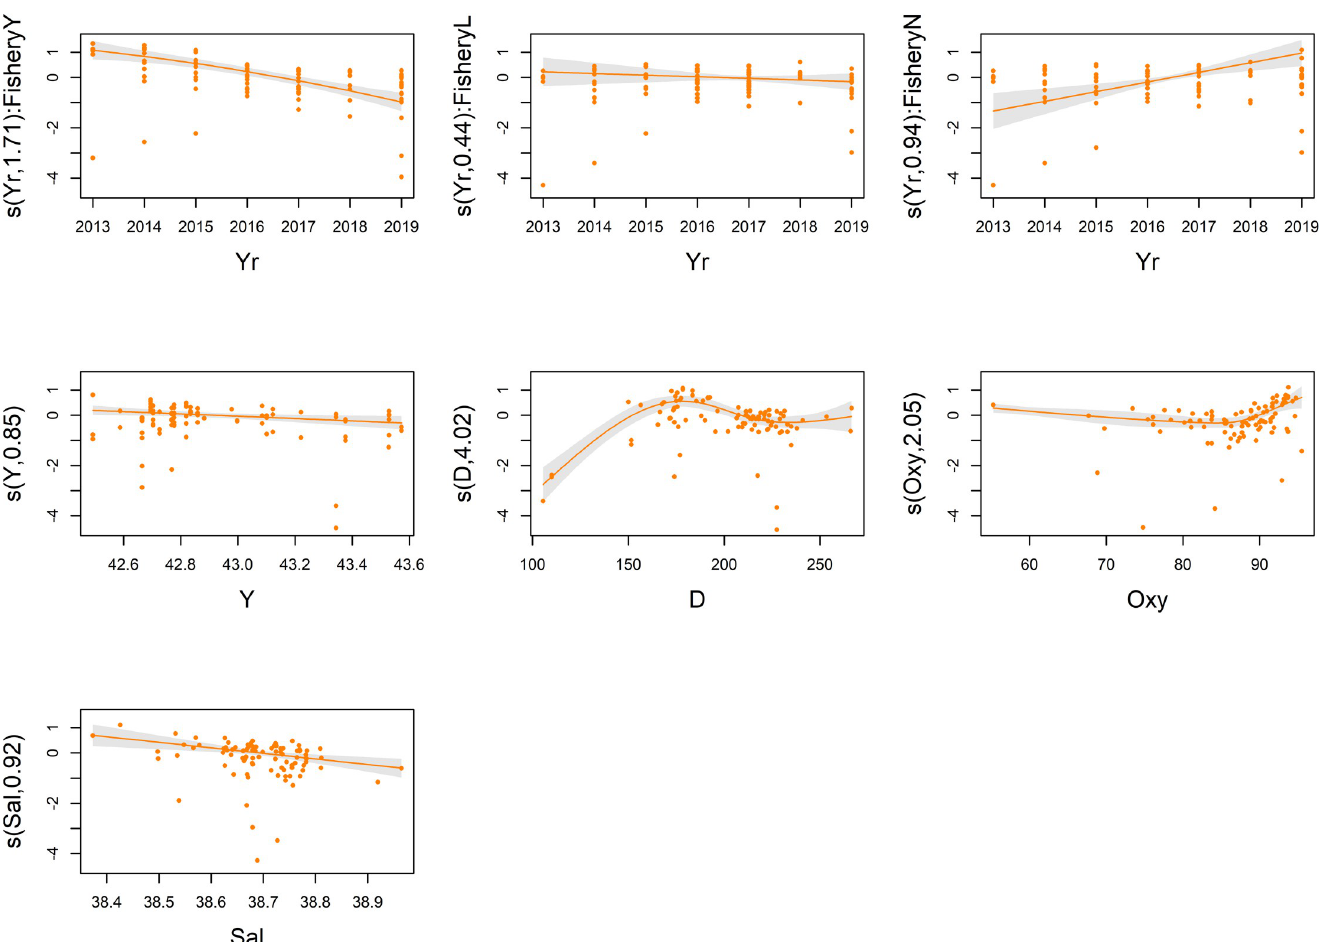
Fig 3. Partial effects plots of GAM on Nephrops CPUE (N/km 2 ). Partial effects (y axis) of spatial (Y, D), environmental (Oxy, Sal), and fishery management variables (Yr:Fishery) selected for the final GAM. Grey shaded regions indicate the 95% confidence intervals, dots are